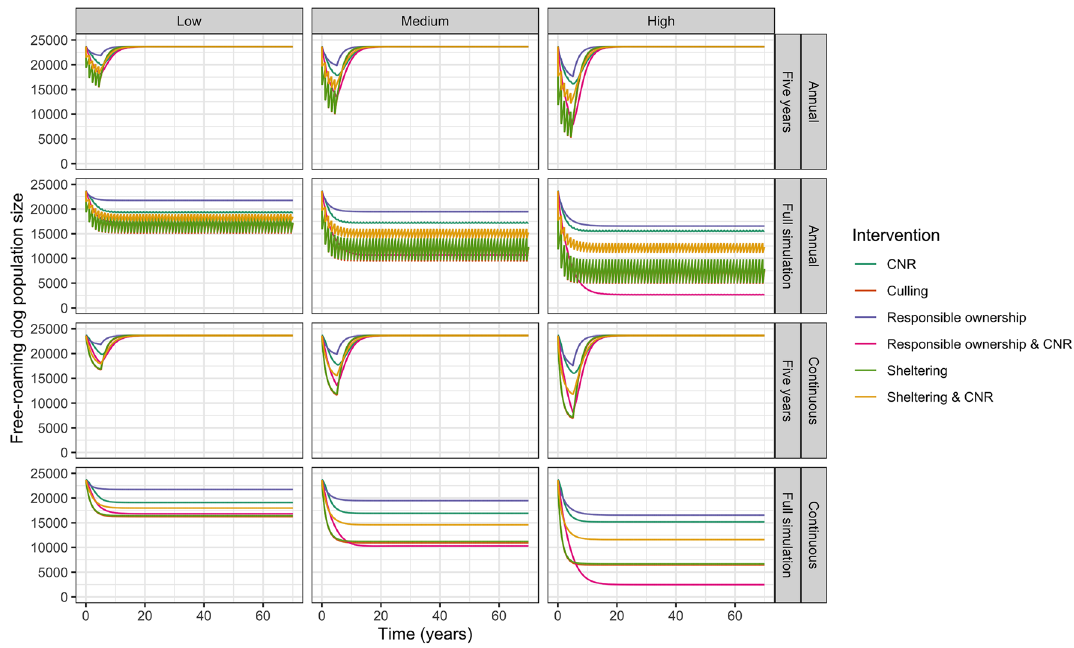
Figure 2. Impact of interventions on free-roaming dog population for simulations run with continuously applied control and five-year period of intervention, when interventions are applied annually and continuously at low, medium, and high coverages.